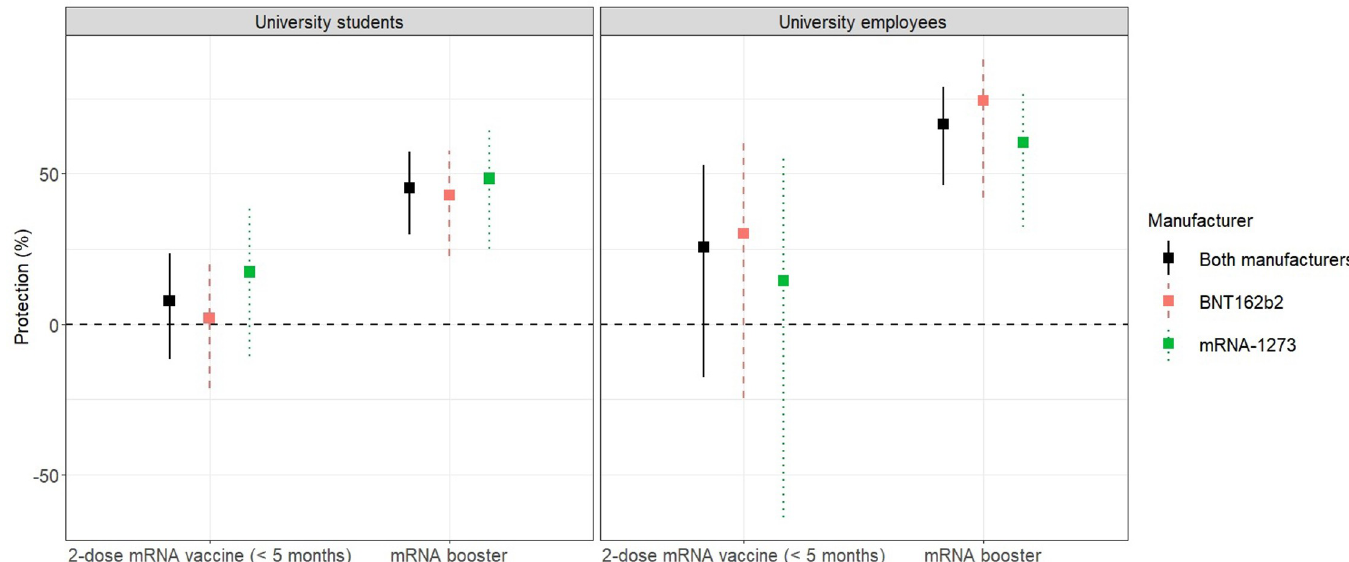
Fig 2. Estimates of (adjusted) vaccine protection against any SARS-CoV-2 infection caused by the omicron variant in university students (left) and employees (right).